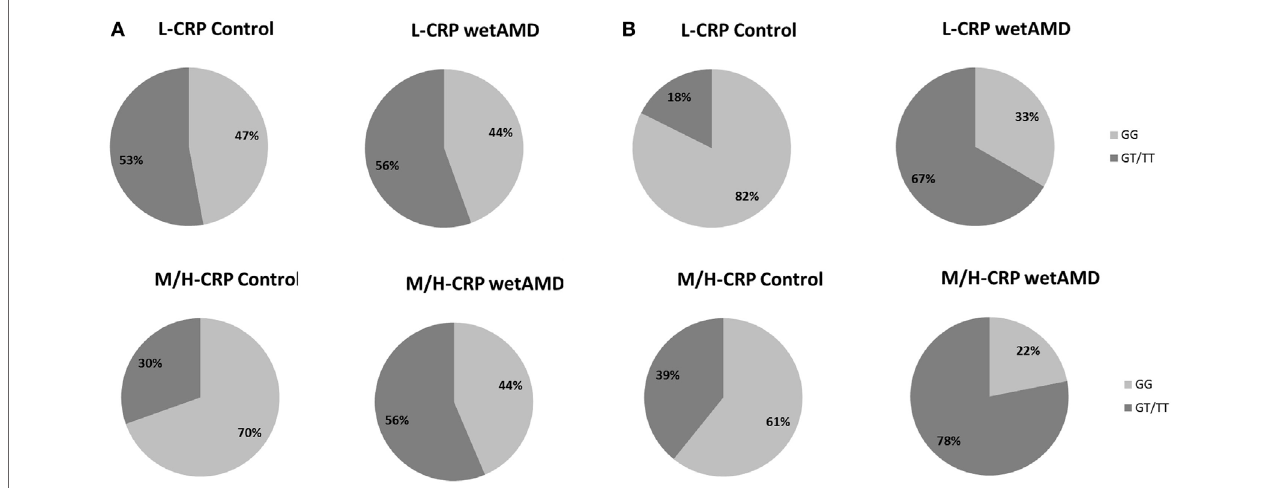
FigUre 3 | Percentage of individuals according to men (a) and women (b) and to C-reactive protein (CRP) stratified groups (L-CRP: upper row and M/H-CRP: lower row) and A69S genotype (light gray: GG and dark gray: GT/TT). L-CRP (low C-reactive protein, < 1 mg/L) and M/H-CRP (moderate-high C-reactive protein, 1.0–10.0 mg/L). Letters T and G: nucleotides for the ARMS2